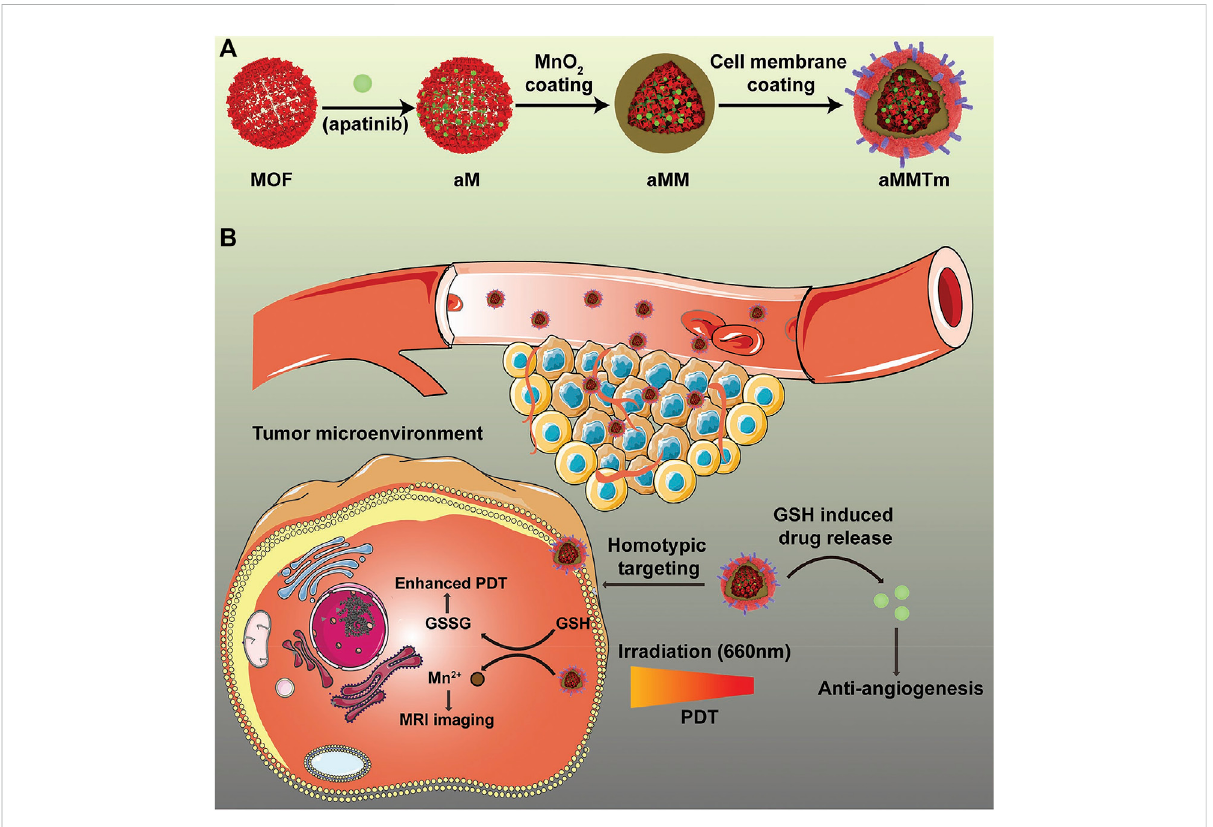
FIGURE 7 Schematic illustration of an integrated nanosystem apatinib-loaded MOFs (aMMTm) preparation and proposed combination therapy of photodynamic therapy and antiangiogenesis. Adapted with permission from Min et al. (2019). (A) The construction of porphyrinic metal-organic framework nanoparticle aMMTm through drug loading, MnO 2 coating and tumor cell membrane decoration. (B) Proposed action mechanism